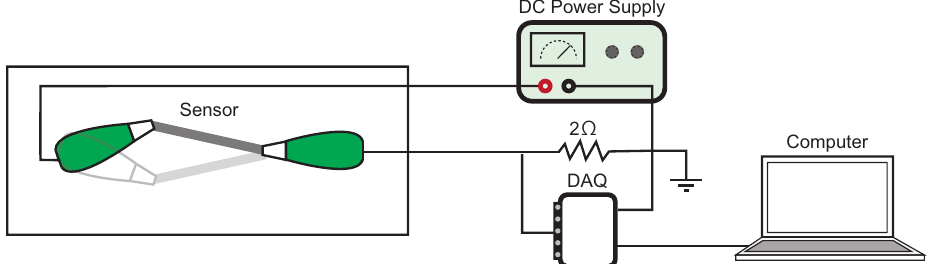
Figure 3. Schematic of the setup used to evaluate the frequency response of the fabricated